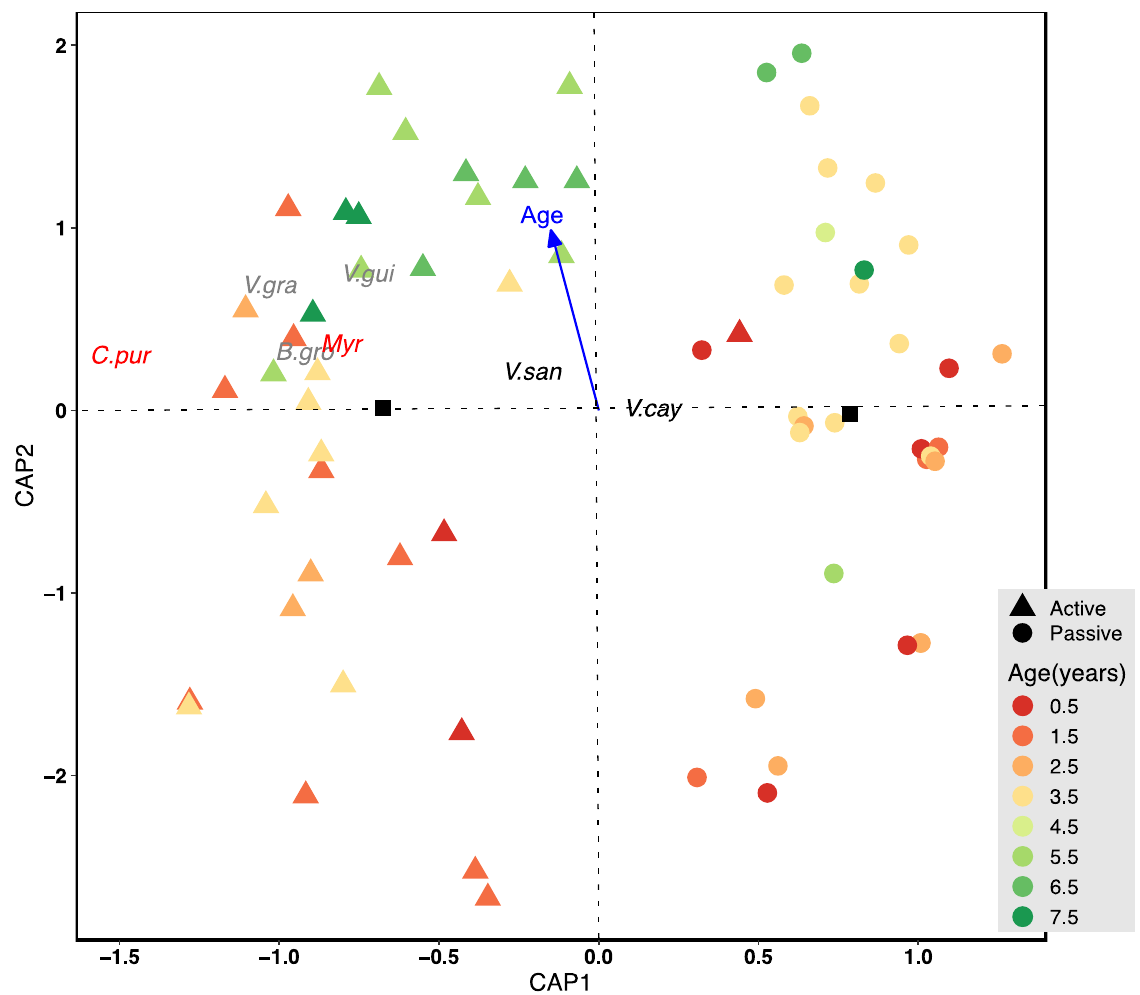
Figure 4. Biplot of the db-RDA of the species composition in 36 active restoration sites (triangle) and 31 natural regeneration sites (circles) located south of Jirau Hydroelectric Reservoir along the upper Madeira River. Black squares represent the centroids of the restoration methods. Abbreviations are the names of the most abundant species sampled in active restoration sites (in red), natural regeneration sites (in black), and both methods sites (three grey names), B.gro: Belluccia grossularioides ; C.pur: Cecropia purpurascens ; Myr: Myrcia sp .; V.cay: Vismia cayennensis ; V.gra: Vismia gracilis ; V.gui: Vismia guianensis ; V.san: Vismia sandwithii .